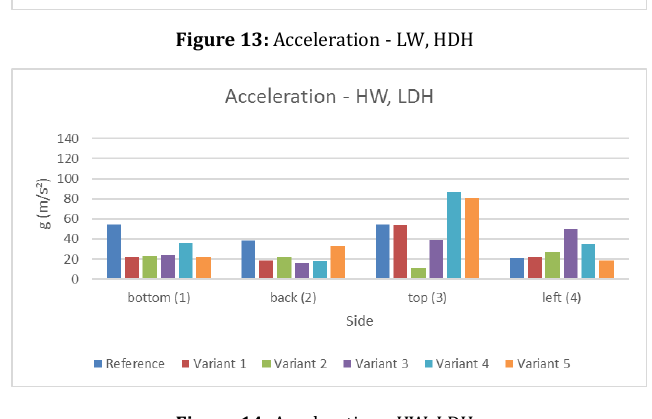
Figure 14: Acceleration - HW, LDH